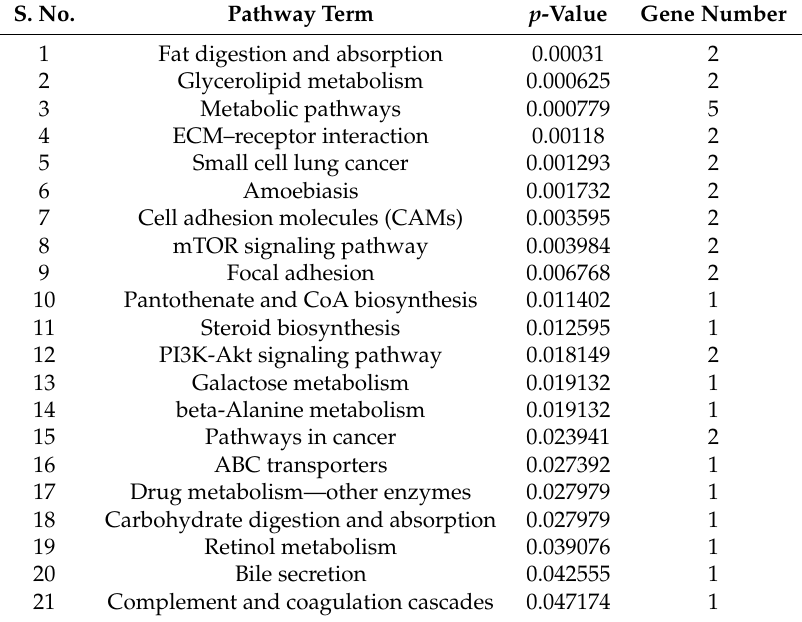
Table 5. Number of substantially enriched pathways along with number of genes of upregulated DEGs computed by KEGG pathway